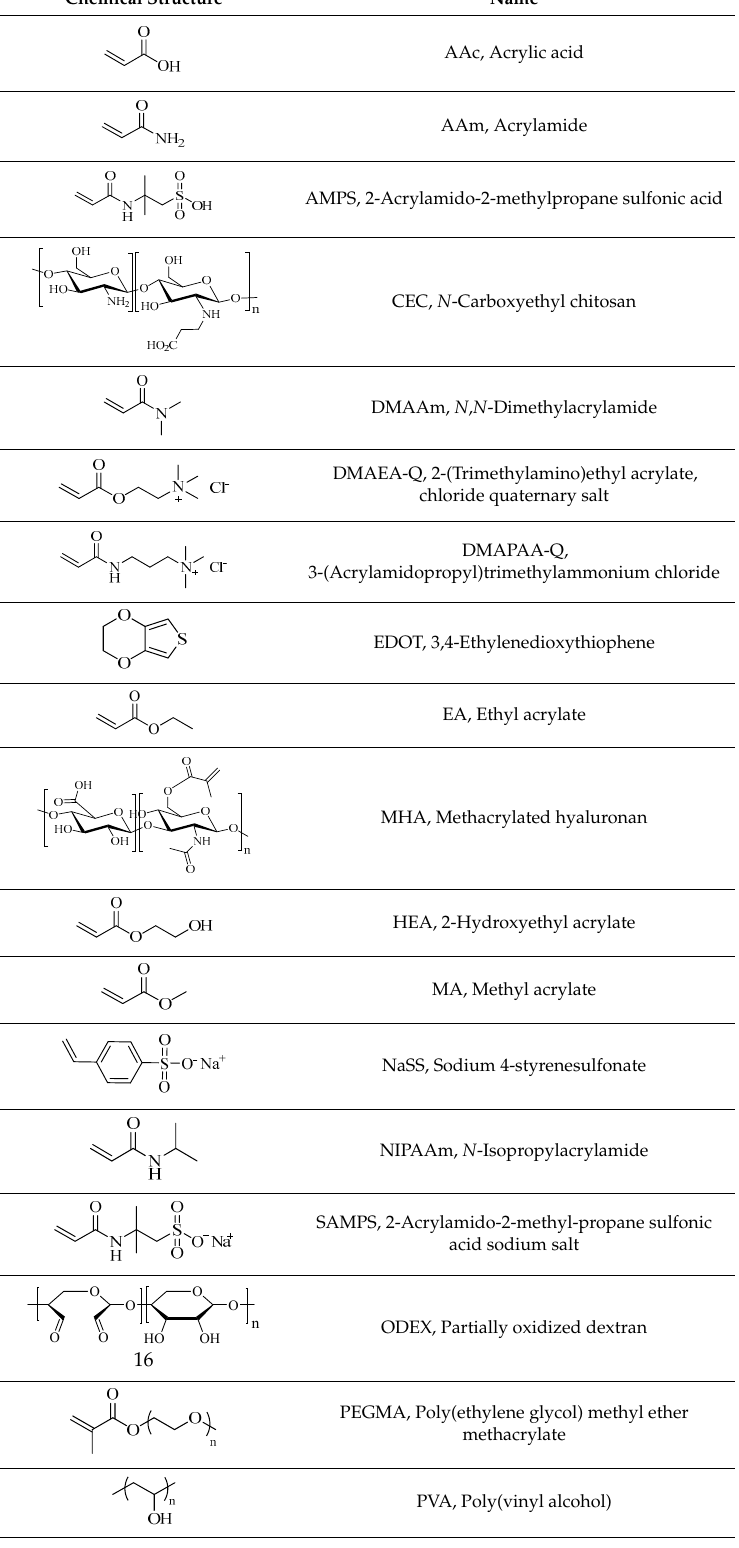
Table 2. Chemical structures and names of monomers and polymers employed in the preparation of the triple-network (TN) hydrogels.